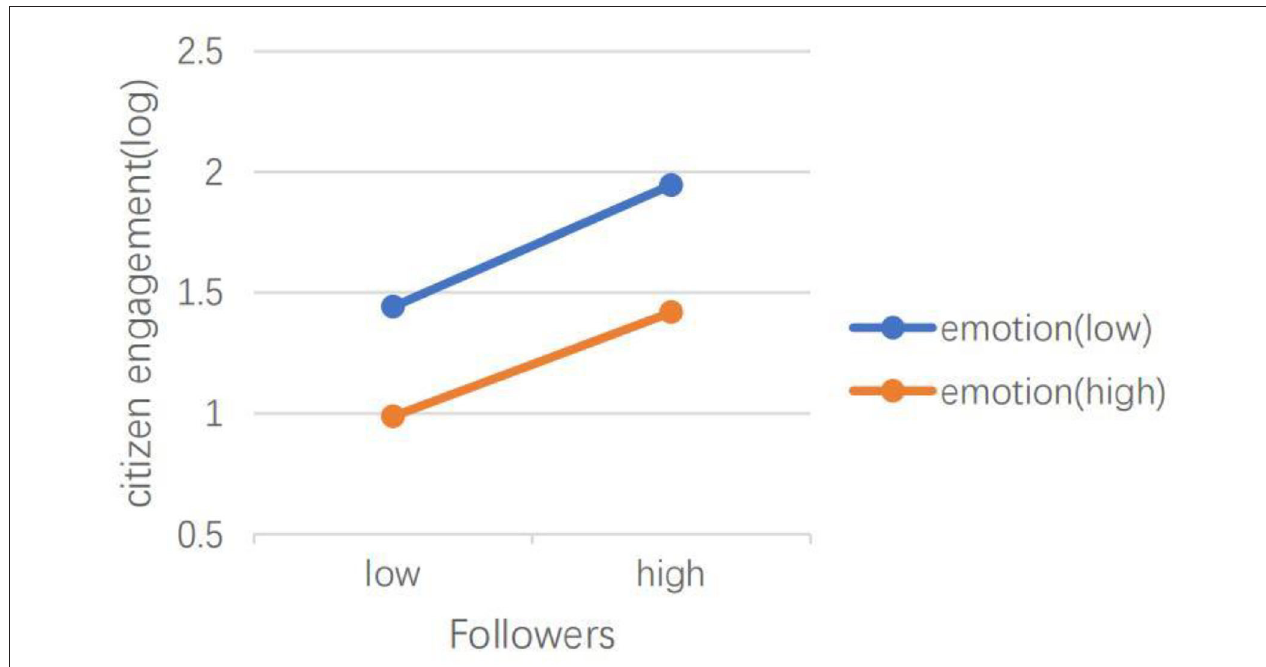
FIGURE 6 | Two-way interaction between the number of followers and emotional valence in predicting CEGSM in the case drop stage.